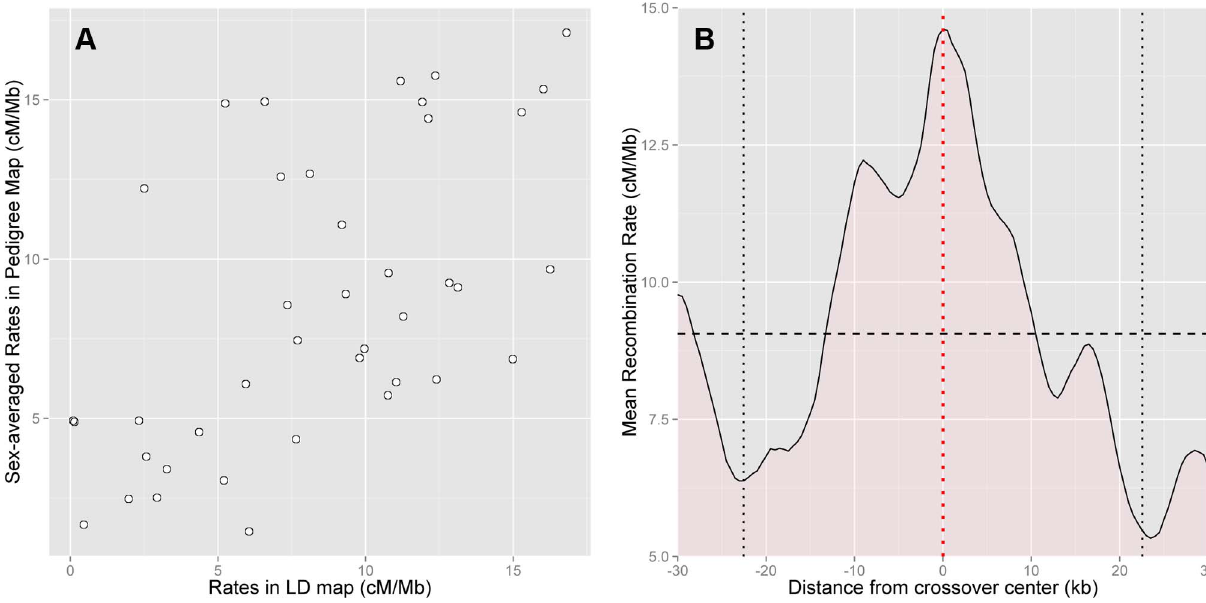
Figure 2. Concordance between pedigree-based and HapMap2 population-averaged LD-based estimates of recombination. (A) Comparison of sex-averaged pedigree rates and LD-based rates at the 50 kb scale shows high correlation (Spearman’s r ~ 0 : 62 , P ~ 1 : 2 | 10 { 6 ). Recombination in PAR1 is dominated by crossovers in males, and the LD-based map is informative about male recombination (Spearman’s r ~ 0 : 63 , P ~ 6 : 7 | 10 { 7 ). (B) Rates in the LD-based map (5 kb scale, at 500 bp intervals) averaged over the best-resolved 10% of paternal crossovers (n=12, resolution 13 kb–45 kb, maximum extent shown by vertical black dotted lines), centred such that they all have their midpoint at 0 (red dotted line). PAR1-wide average LD-based rate of 9.06 cM/Mb is shown with the horizontal black dashed line. The LD-based map has a rate significantly elevated above the average rate at crossover midpoints ( P ~ 0 : 0004 ).